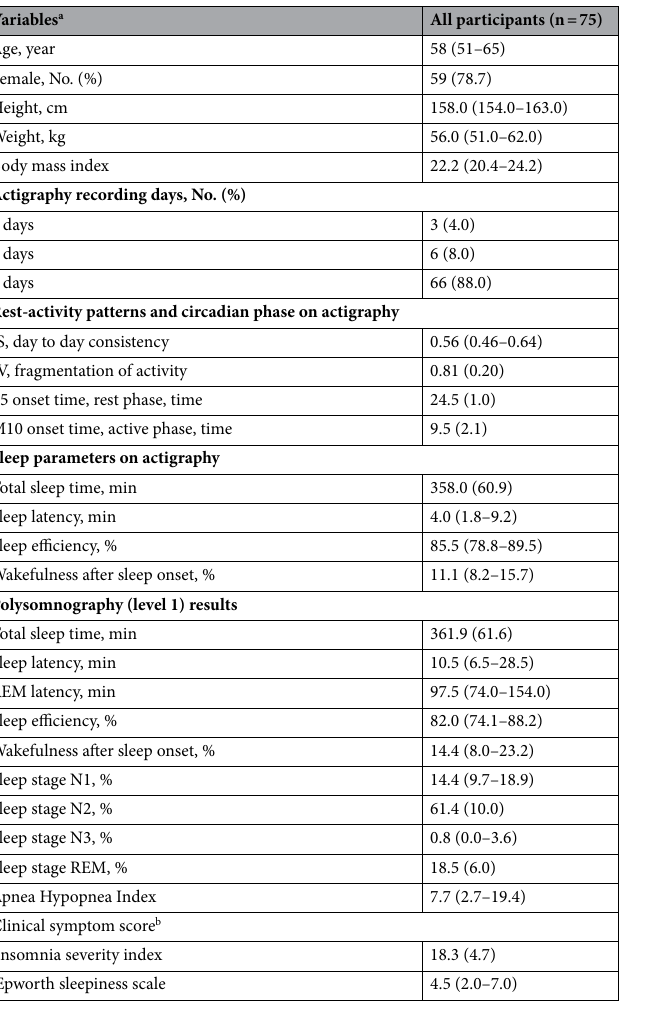
Table 1. Demographic characteristics, rest-activity patterns, circadian phase, and level 1 PSG parameters of study participants. IQR interquartile range, IS inter-day stability, IV intra-daily stability, L5 onset time least active 5-h onset time, M10 onset time most active 10-h onset time, SD standard deviation. a Values are presented as mean (SD) for normally distributed continuous variables, median (IQR) for non-normally distributed continuous variables, and number (%) for categorical variables. b Five participants did not complete the insomnia severity index (n = 70), and one participant did not complete the Epworth sleepiness scale (n =